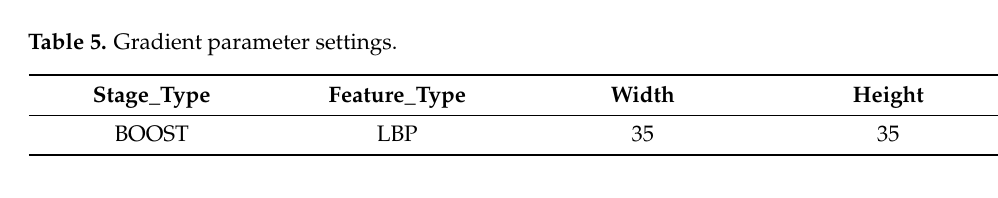
Table 6. Enhanced classifier parameter